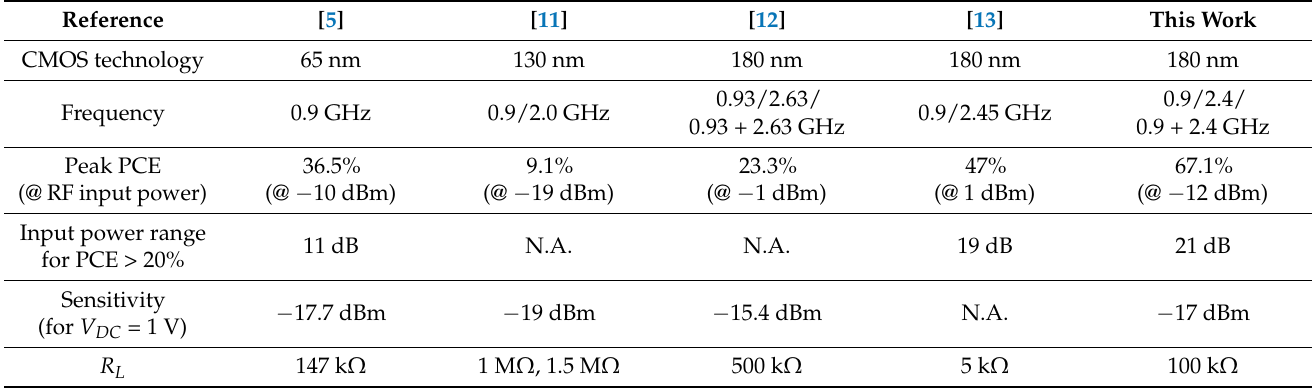
Table 2. Performance summary and